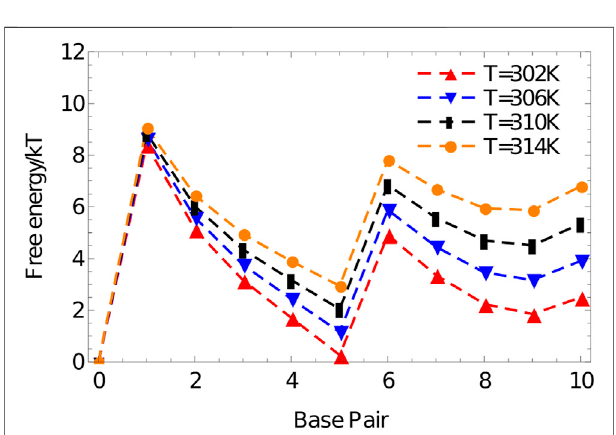
FIGURE 10 | Free energy vs number of base pairs formed for the complex 3 ′ -AGCTTCCATG-5 ’ /3 ′ -AAGCTCATGG-5 ′ in a simulation volume of side length 20 oxDNA